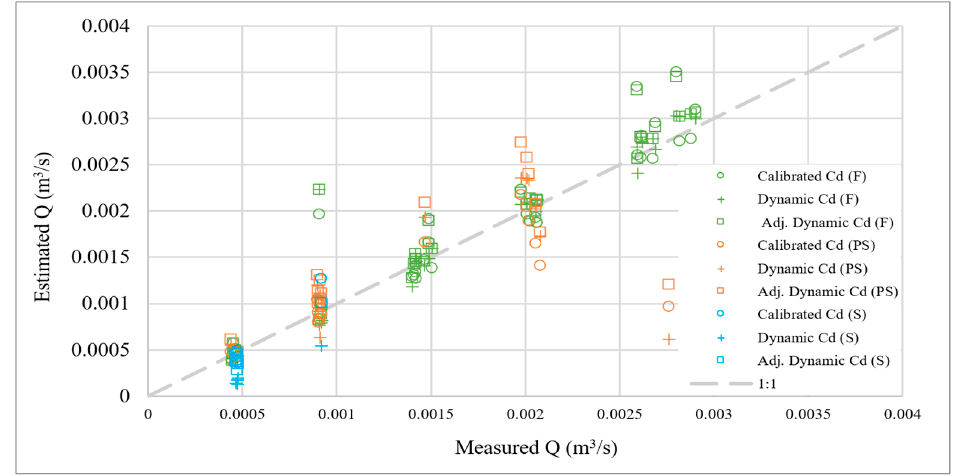
Figure 7. The estimated volumetric flow rate of methods to estimate C d for HEC-RAS. Table 4. The estimated 𝐶 (cid:3031) for HEC-RAS and the evaluation criteria for estimated flow rates. Flow Regime